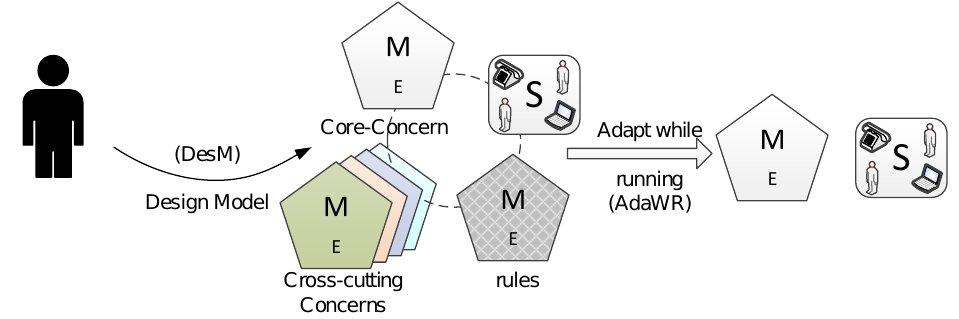
Figure 4. The Dynamic Weaving use case